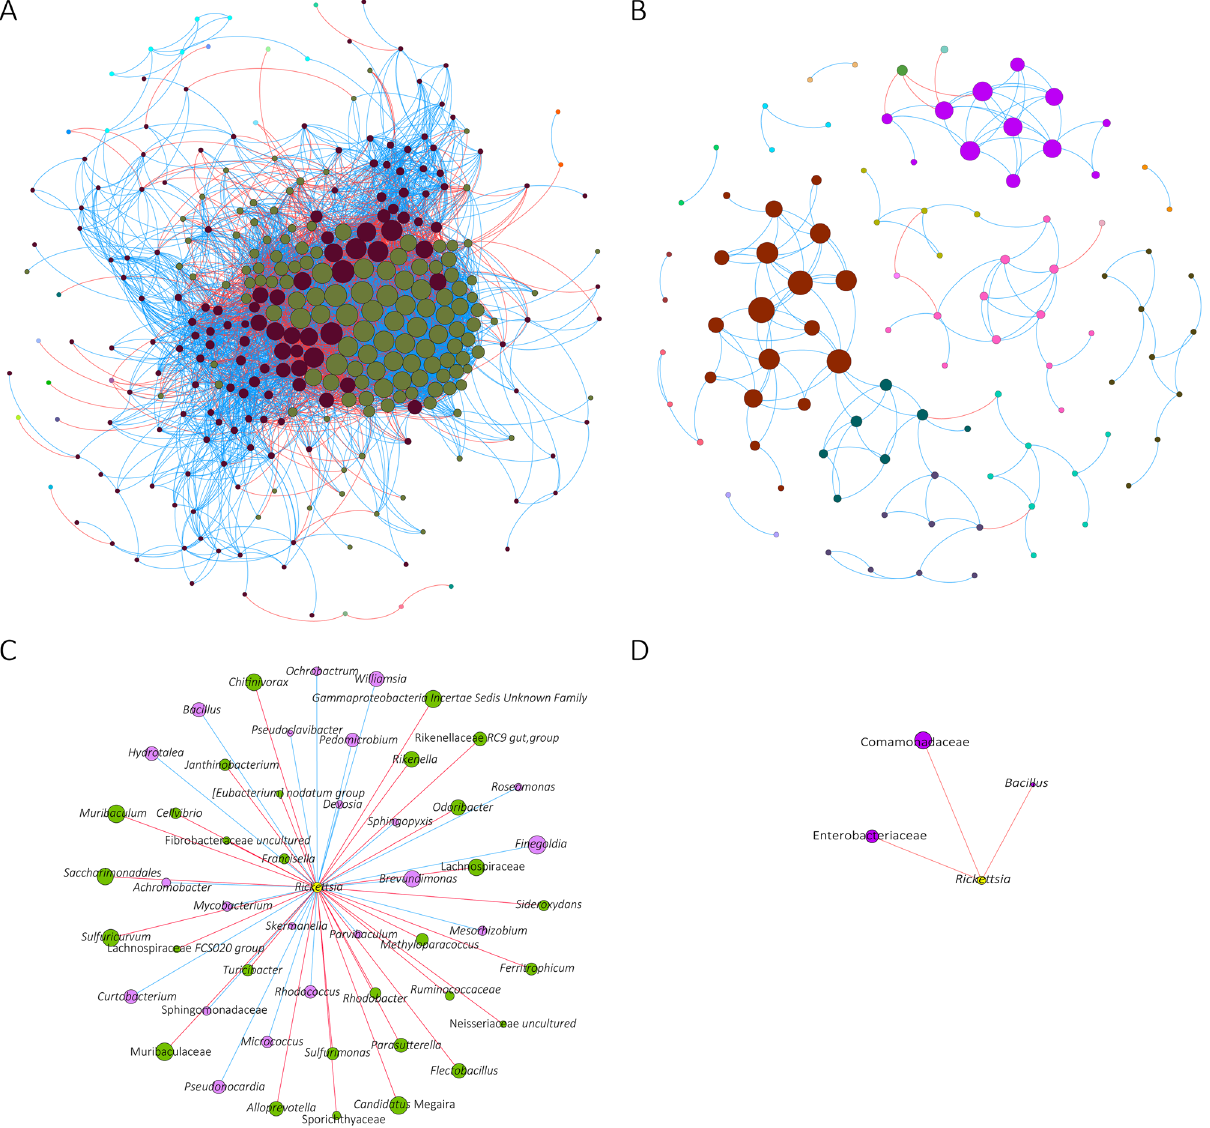
Figure 3. Global and local co-occurrence networks. Co-occurrence networks of ( A ) pathogen-free and ( B ) R. helvetica -positive samples. The direct neighbors of Rickettsia were identified in the bacterial co-occurrence networks of ( C ) pathogen-free and ( D ) R. helvetica -positive samples and represented as sub-networks. Nodes correspond to taxa (family or genera level), and connecting edges indicate significant connection between them ( p < 0.01). Only nodes with at least one significant correlation are represented. Node colors are based on modularity class metric and equal color means modules of co-occurring taxa. The size of the nodes is proportional to the eigenvector centrality of each taxon. The colors in the edges represent strong positive (blue) or negative (red) correlations (SparCC > 0.75 or < − (Fig. 5A). The pathogen-free and R. helvetica- positive ticks also had 412 (97.4%) of the 423 total functional path- ways in common (Fig. 5B). Bray–Curtis index and a PERMANOVA test demonstrated that the beta-diversity of enzymes (Fig. 5C) and pathways (Fig. 5D) was not significantly different between the two datasets. However, an ANOVA test demonstrated that the number of predicted enzymes of pathogen-free samples were more variable than the R. helvetica infected one (Fig. 5C). Differential analysis showed that the relative abundance of predicted genes (KO) encoding 13 enzymes (Fig. 5E) and 2 pathways (Fig. 5F) changed significantly between the two data- sets. These 13 enzymes were involved in various metabolic functions including energy metabolism (methane and nitrogen metabolism), amino acid metabolism (arginine and proline metabolism as well as glycine, serine and threonine metabolism), glycan metabolism (glycan biosynthesis), nucleotide metabolism (purine metabo- lism), pyruvate metabolism, carbohydrate metabolism (glyoxylate and dicarboxylate metabolism) and steroid degradation (Fig. 6). In the methane metabolism pathways, the methane monooxygenase (EC:1.14.18.3) and methylamine dehydrogenase (EC:1.4.9.1) had a significantly lower and higher abundance, respectively, in the R.